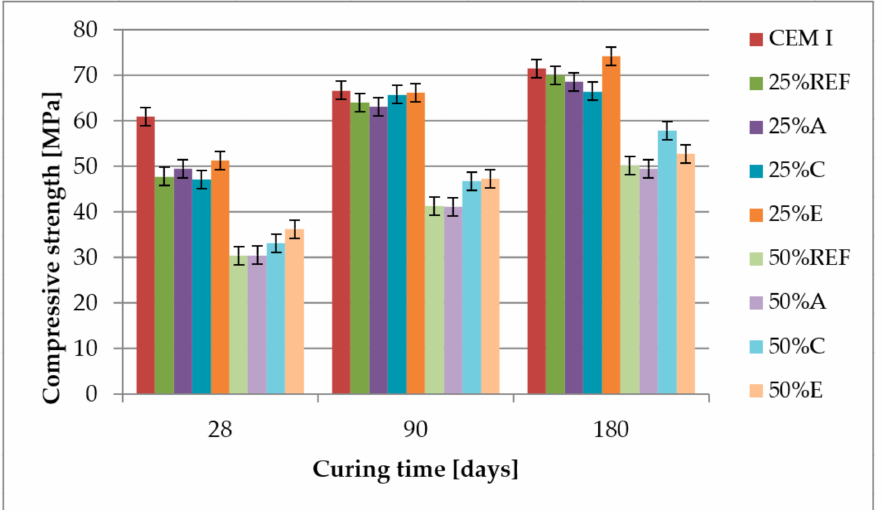
Figure 6. Compressive strength of